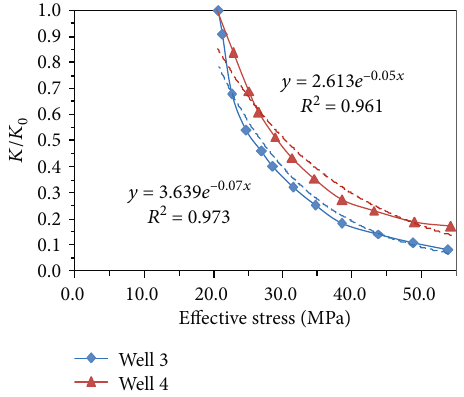
Figure 8: Stress-strain experiment results of Well 3 and Well